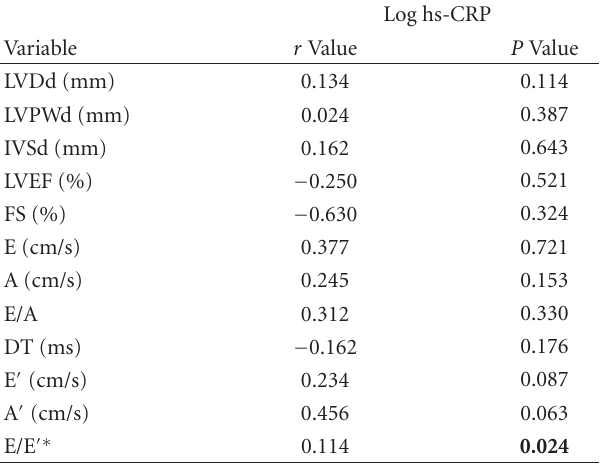
Table 5: Correlation coe ffi cients of linear regression analysis between hs-CRP and echocardiographic parameters in patients group.